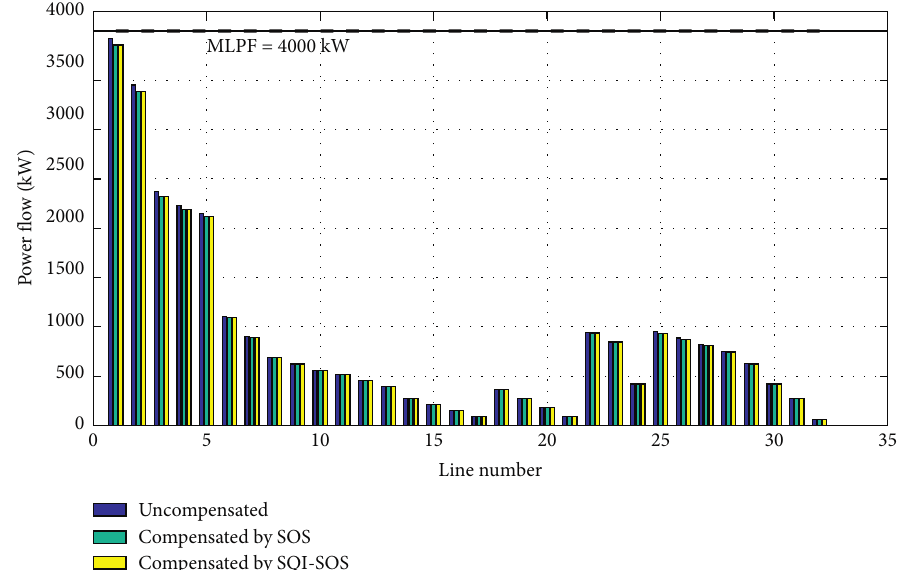
Figure 4: Comparison of lines power flow of the 33-bus system before and after compensation with the CP load model at 100% loading.